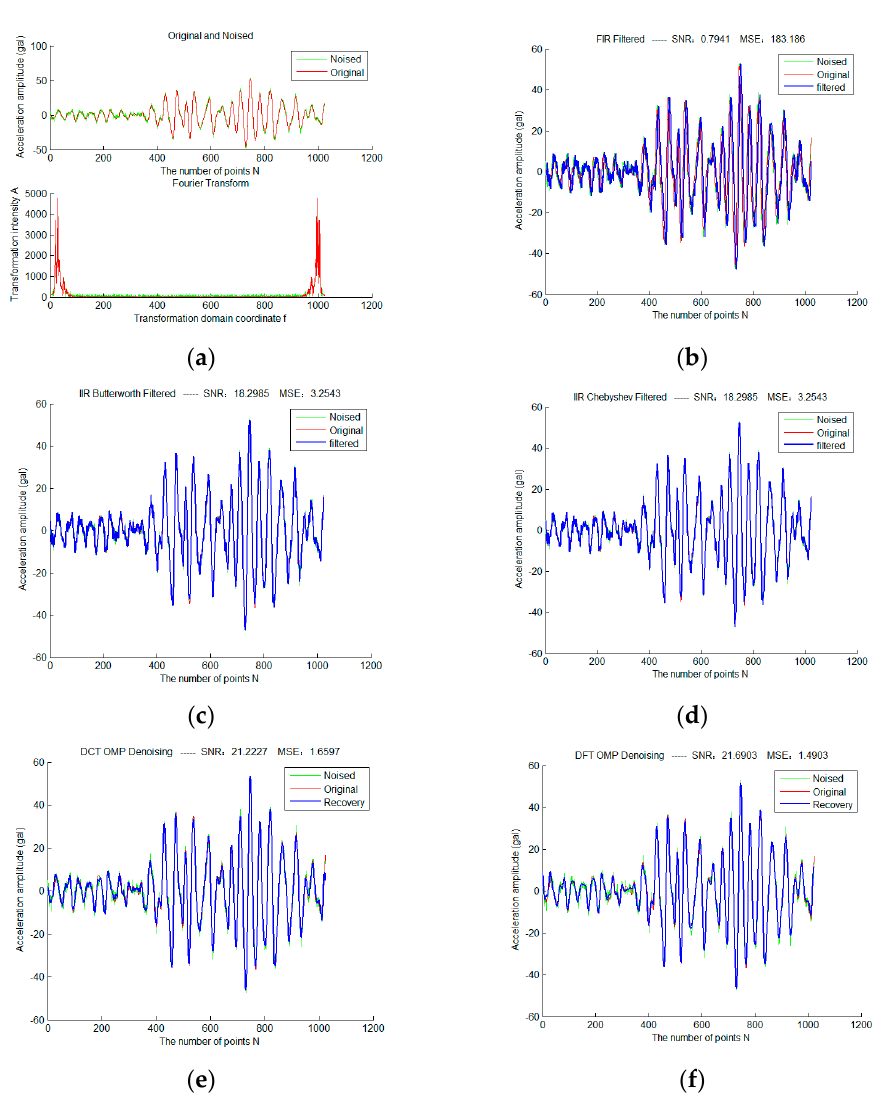
Figure 4. Sparse Denoising Experiment of a Frame of Strong Earthquake Signals Based on Different Fixed Dictionary ( a ) is the original and noise-adding waveforms of the frame signal in the time and frequency domain (sigma = 2); ( b ) is the result based on FIR filtering; ( c ) is the result based on Butterworth filtering; ( d ) is the result based on Chebyshev filtering; ( e ) is the OMP sparse denoising result based on the DCT dictionary; ( f ) is the OMP sparse denoising result based on the DFT dic- tionary.